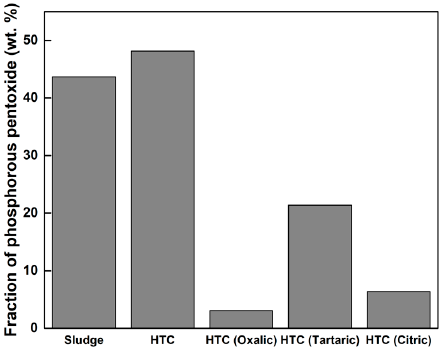
Figure 3. Fraction of phosphorus pentoxide in the ash of sludge and the HTC products with different organic acids.